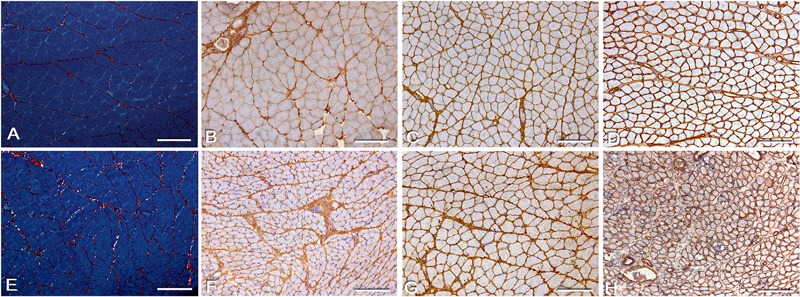
Photomicrographs of soleus muscle: labeling of connective tissue elements. Cross-sections of soleus muscle were stained with picrosirius red and immunolabeled for collagen types I, III, and IV. A and E: picrosirius red; B and F: collagen type I immunolabeling; C and G: collagen type III immunolabeling; D and H: collagen type IV immunolabeling. A (CG30) shows moderate to strong picrosirius red staining; E (ISG) shows strong picrosirius red staining; B (CG30) shows weak labeling for collagen type I; F (IG) shows moderate labeling for collagen type I; C (CG30) shows moderate labeling for collagen type III; G (SG) shows moderate to strong labeling for collagen type III; D (CG30) shows moderate to strong labeling for collagen type IV; H (ISG) shows moderate to strong labeling for collagen type IV. Bars: 50 µm. CG21: 21-day control group; CG30: 30-day control group; IG: immobilized group; ISG: immobilized and stretched group; SG: stretched group.